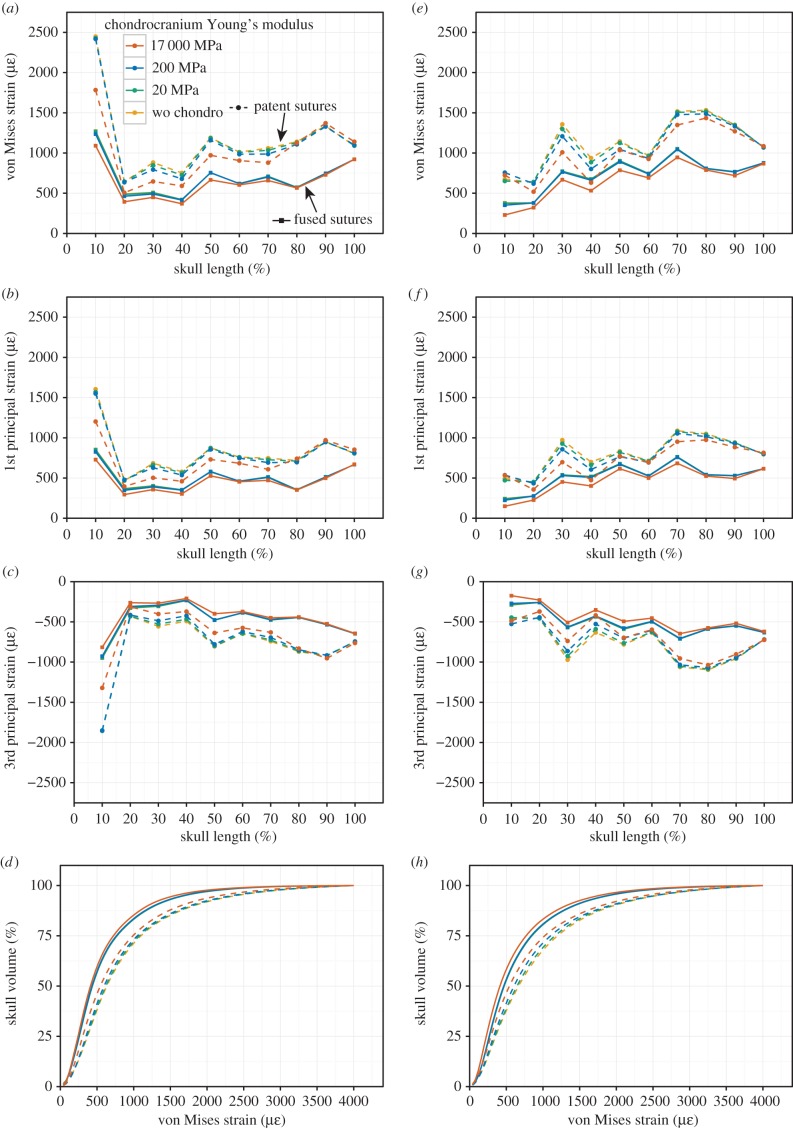
Strain plots for the cranium during (a–d) anterior biting and (e–h) posterior unilateral biting. (a,e) von Mises strain, (b,f) 1st principal strain, (c,g) 3rd principal strain and (d,h) cumulative strain plots. Dashed line = patent sutures.